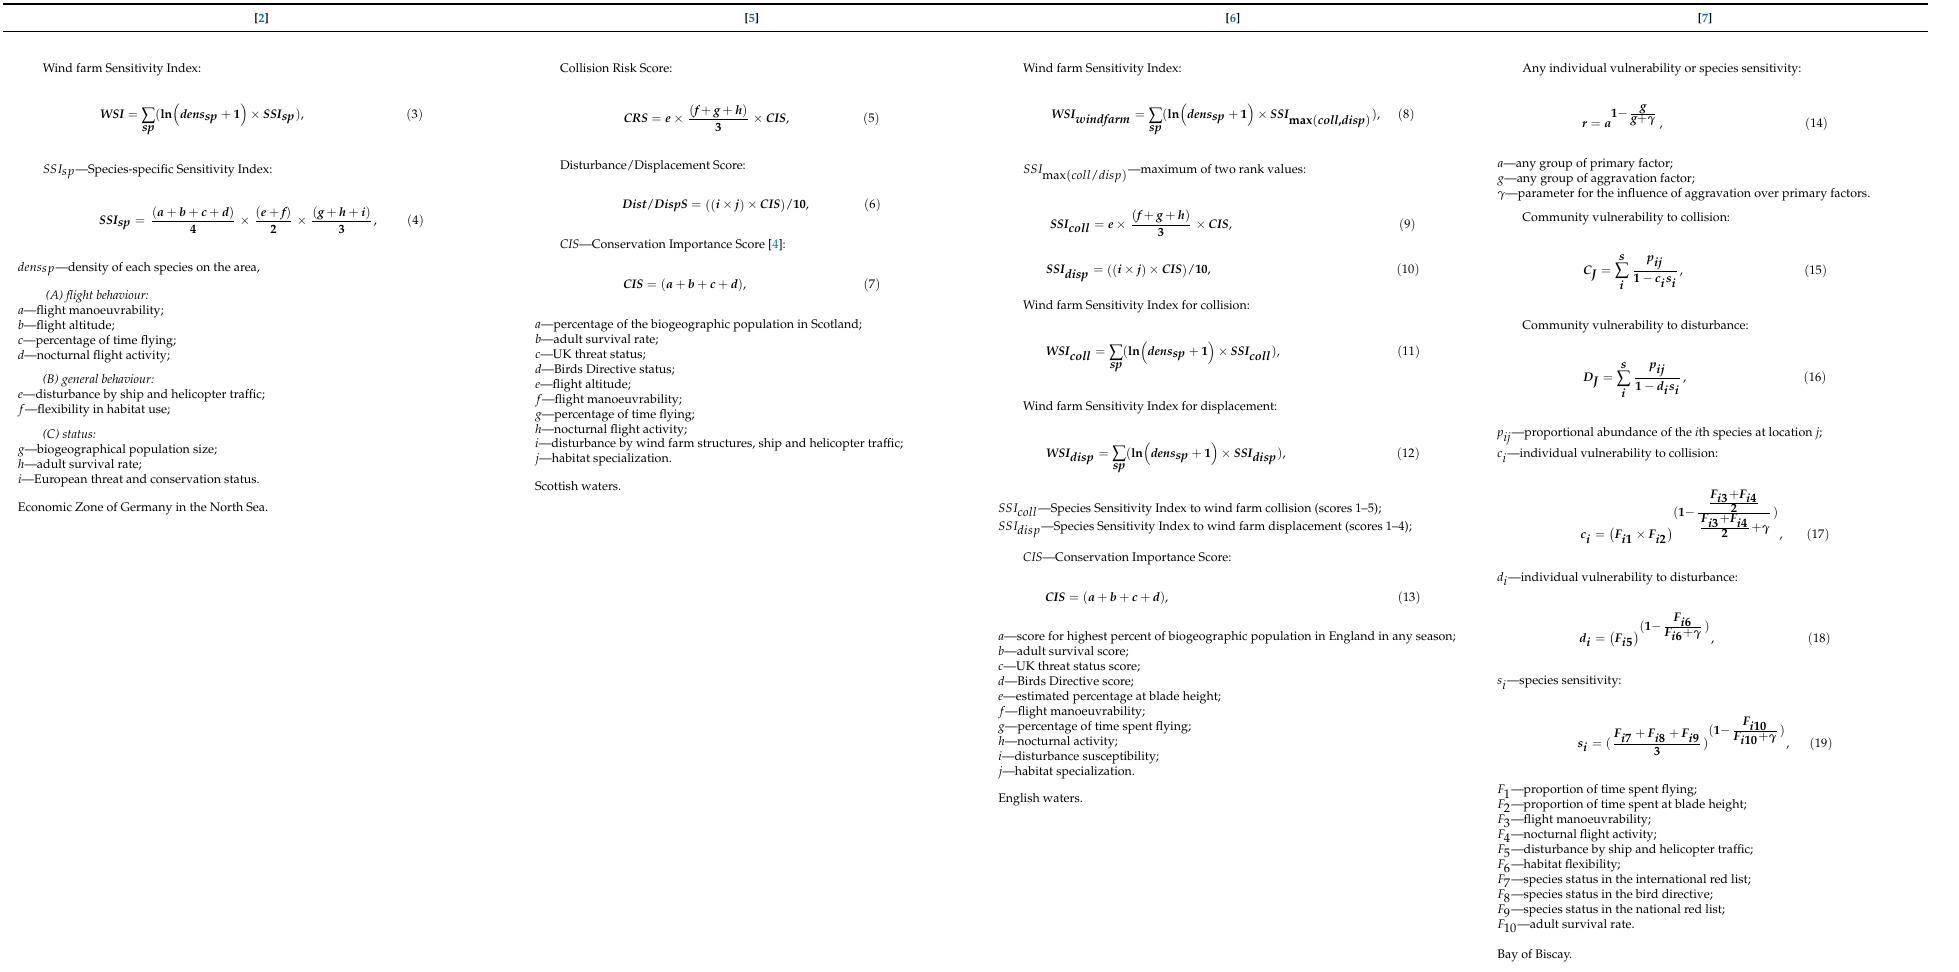
Table 2. Mathematical models and used designations of the initial data, given in the discussed publications (designations of quantities, given in the original articles, remain unchanged; some designations are contracted, though the expansions of abbreviations are given; see detailed explanations in the original